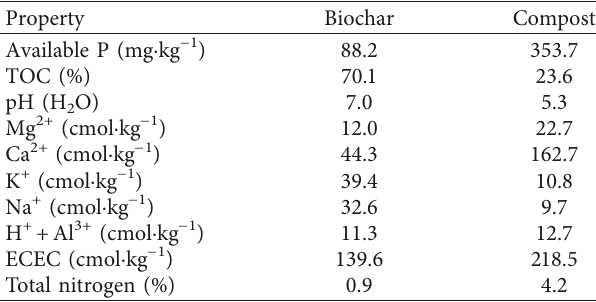
Table 2: Chemical properties of biochar and compost used in the experiment.